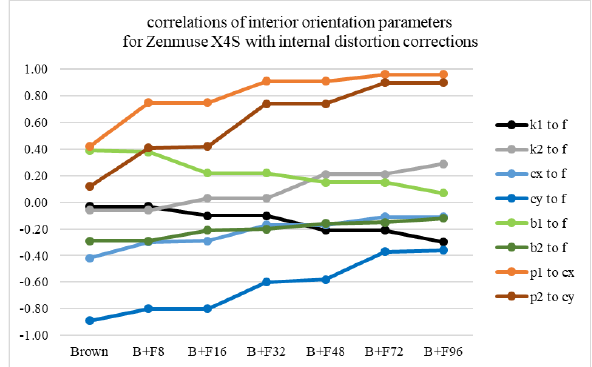
Figure 10. Resulting correlations of different interior orientation parameters for ZenmuseX4s (data set 2).